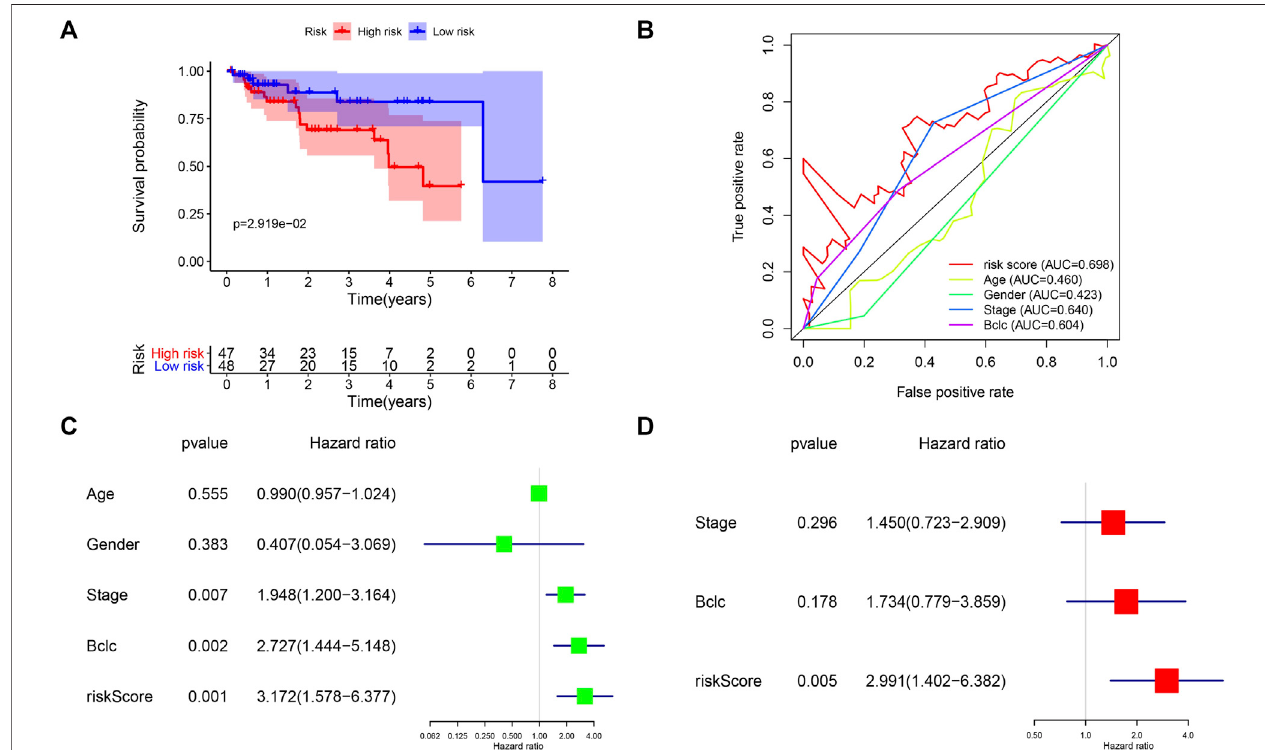
FIGURE 6 | External validation of the four-mRNA signature in GEO cohort. (A) Survival analysis of different risk groups in the GEO cohort. (B) ROC curves validate thesensitivityandspeci fi cityoftheriskmodelinthetrainingset. (C) UnivariateregressionanalysisofclinicalcharacteristicsandriskscoreaffectingpatientOSintheGEO cohort. (D) Multivariate regression analysis of clinical characteristics and risk score affecting patient OS in the GEO cohort.